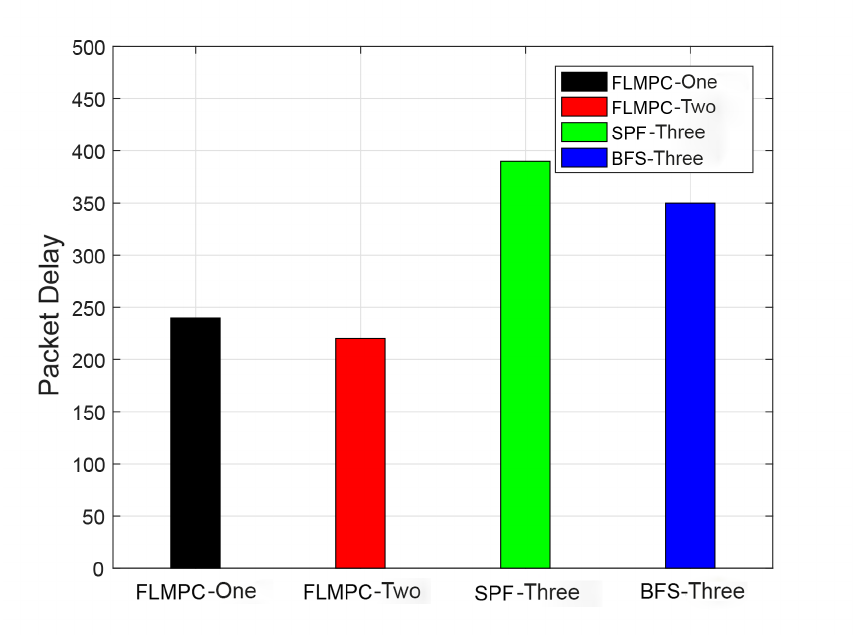
Figure 10. Packet Delay